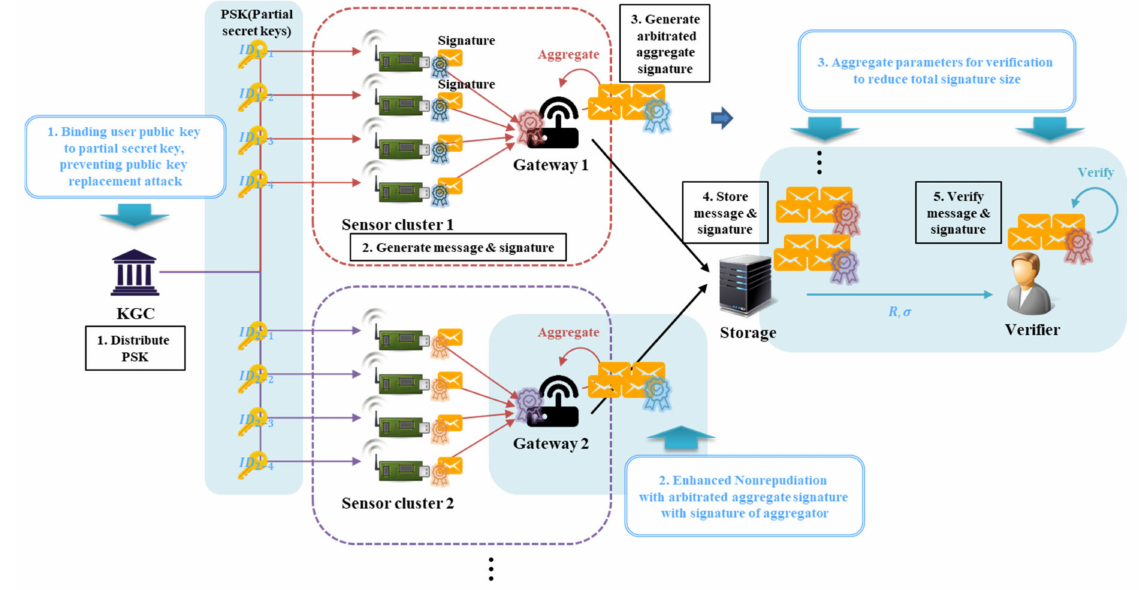
Figure 3. Scenario and advantages of the proposed scheme. KGC: key generation